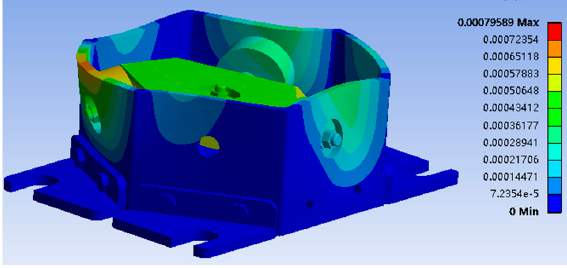
Figure 17. Deformation image of the sensor. Table 7. Axial deformations of the four branches.